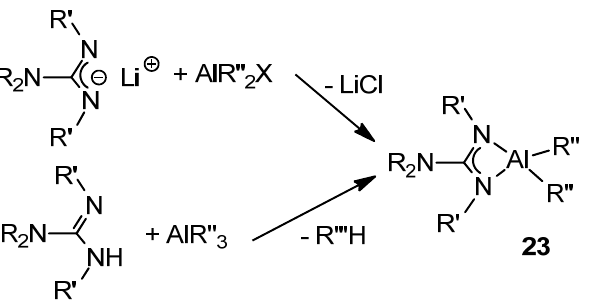
Figure 16. Synthesis of organoaluminum guanidinato complexes.